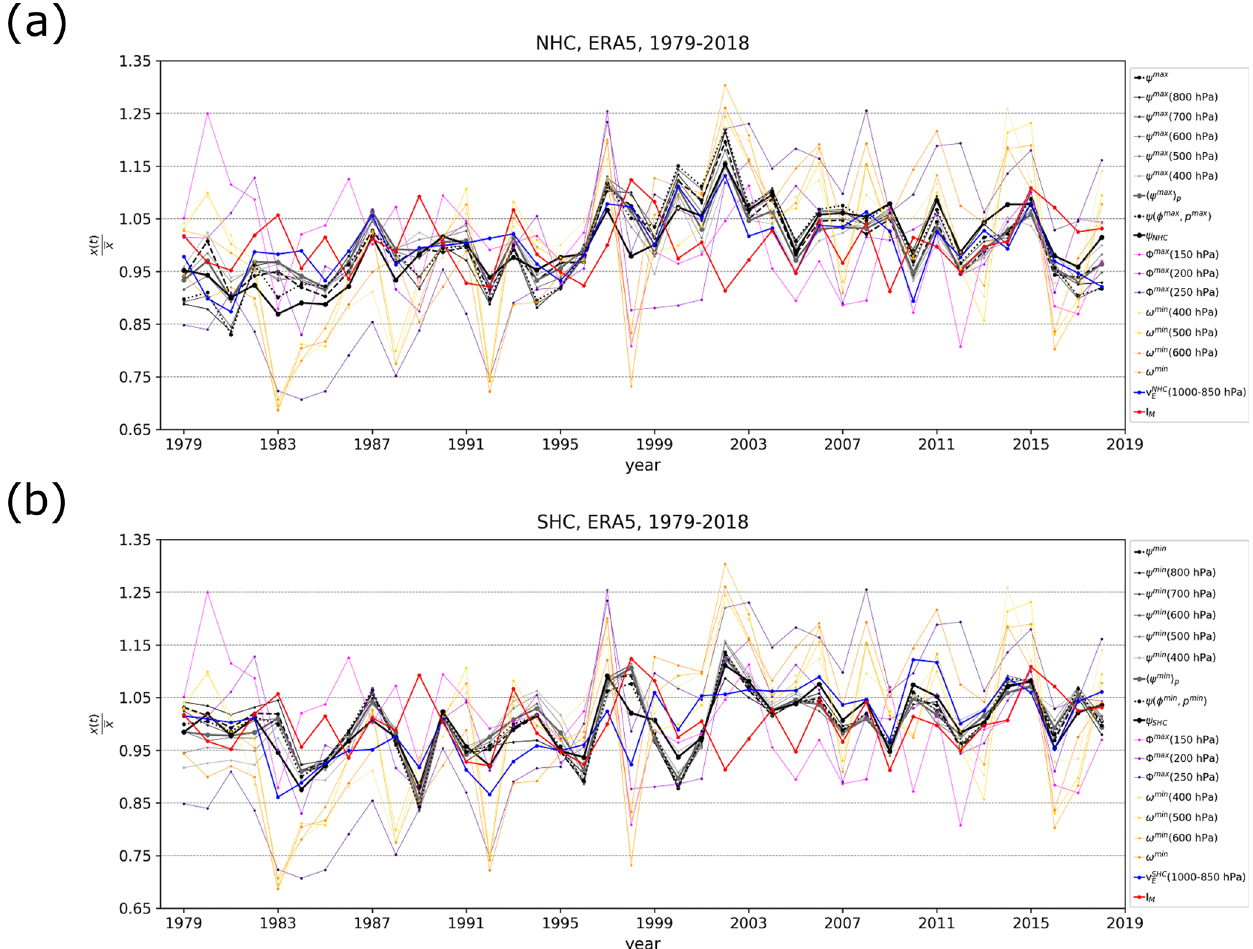
Figure 3. Time series of NHC strength (a) and SHC strength (b) in ERA5 reanalysis between 1979 and 2018 for different metrics from Sect. 2.2. Time series are normalized by their 1979–2018 climatological mean. Different stream-function metrics of HC strength are shown in the legend (in grey colours), e.g. in (a) for the NHC: ψ max denotes the annual/seasonal stream-function maximum (metric 1); ψ max at 800, 700, 600hPa etc. denotes the annual/seasonal stream-function maximum at respective pressure level (metric 2); ψ (cid:0) ϕ max ,p max (cid:1) denotes that HC strength is measured at the point of the maximum stream function in a multiyear average of NHC strength (metric 3); (cid:10) ψ max (cid:11) the vertically averaged ψ max between 200 and 900hPa (metric 4, Eq. 2); ψ NHC denotes the average stream-function metric (7); and v NHC denotes effective wind for the lower tropospheric water vapour transport (metric 8, blue colour). Analogous notations are used for the SHC in (b) . The following metrics do not distinguish between the two Hadley cells, but describe the Hadley circulation as a whole (their time series are thus the same for the NHC in a and SHC in b ): (cid:56) max (p) denotes the maximum of the zonal-mean velocity potential at different pressure levels (metric 5, violet colours); ω min (p) denotes the minimum of the zonal-mean vertical velocity (metric 6, orange colours); and I M denotes the normal-modes-based metric of the Hadley circulation (metric 9, red